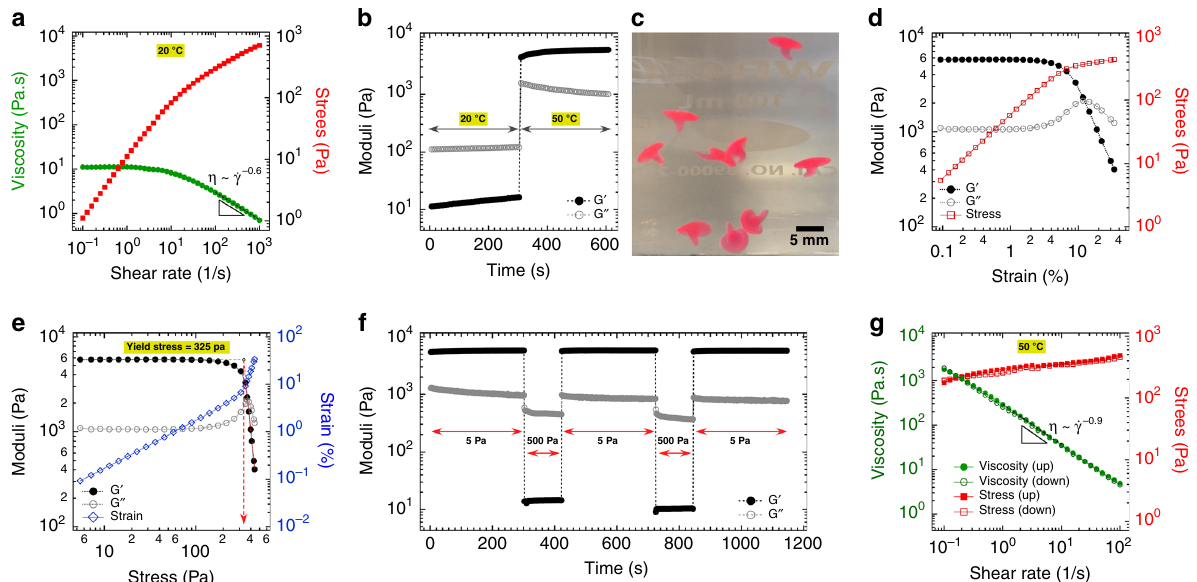
Fig. 6 Rheological characterization of the thermogelling nanoemulsion below (20 °C) and above (50 °C) the gel point. a Steady shear rheology at 20 °C. b Viscoelastic moduli in a temperature jump from sol state (20 °C) to gel state (50 °C); ( γ 0 = 0.1% and frequency of 20 rad/s). c Optical image of mushroom-shaped gel particles formed by dripping a room temperature thermogelling nanoemulsion (using a 15-gauge needle) into a hot water bath at 50 °C. Large amplitude oscillatory shear experiment (frequency of 20 rad/s) plotted vs. d strain amplitude, and e shear stress. The dashed red line with an arrow in panel e indicates the yield stress. f Change in the moduli indicating breaking and recovery of the structure under applied stresses of 500 Pa and 5 Pa, respectively ( γ 0 = 0.1% and frequency of 20 rad/s). g Cyclic fl ow sweep experiment from low to high shear rate (up) and from high to low shear rate (down) at 50 °C. Dash lines in a and g are power-law fi ts to the